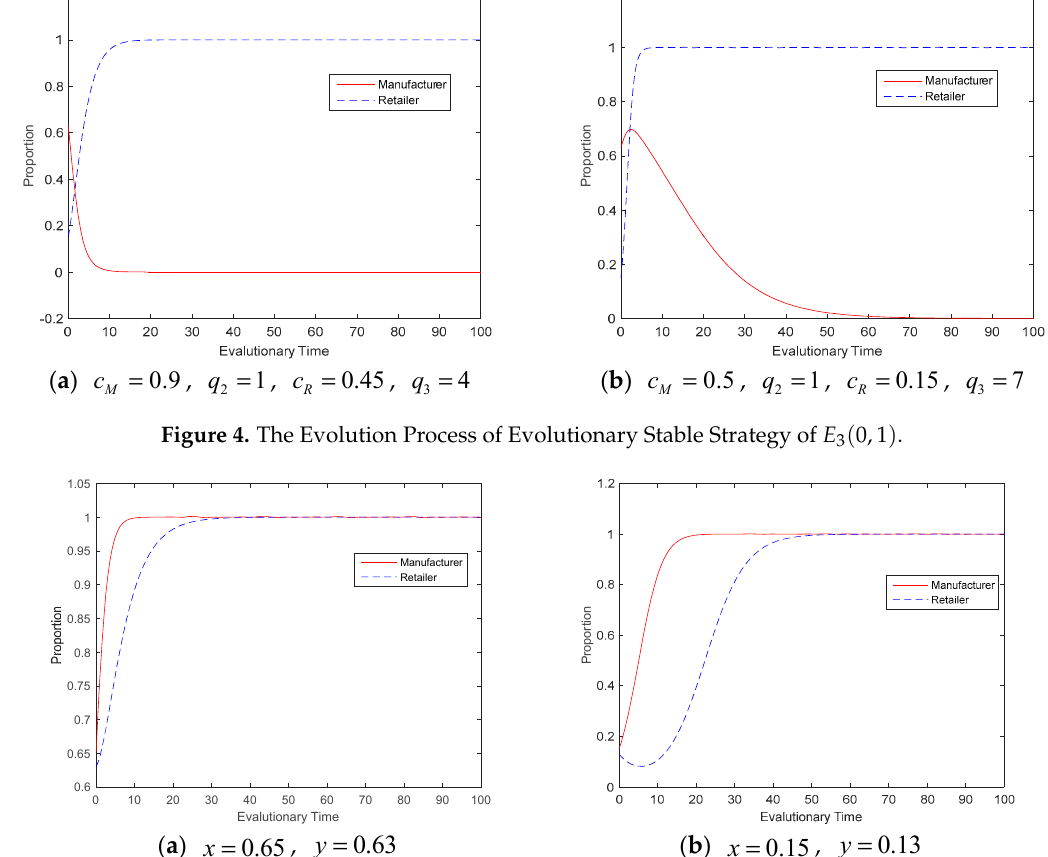
Figure 5. The Evolution Process of Evolutionary Stable Strategy of